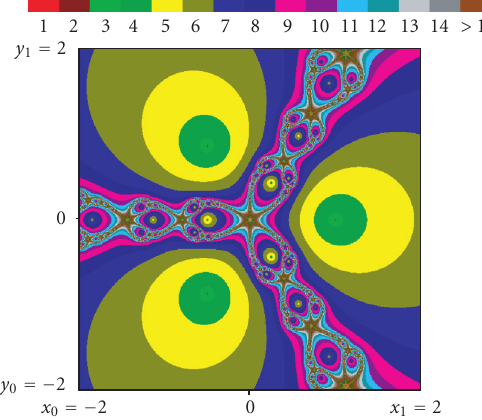
Figure 5.8. The figure shows the basins of attraction for Newton’s method applied to the equation z 3 − 1 =